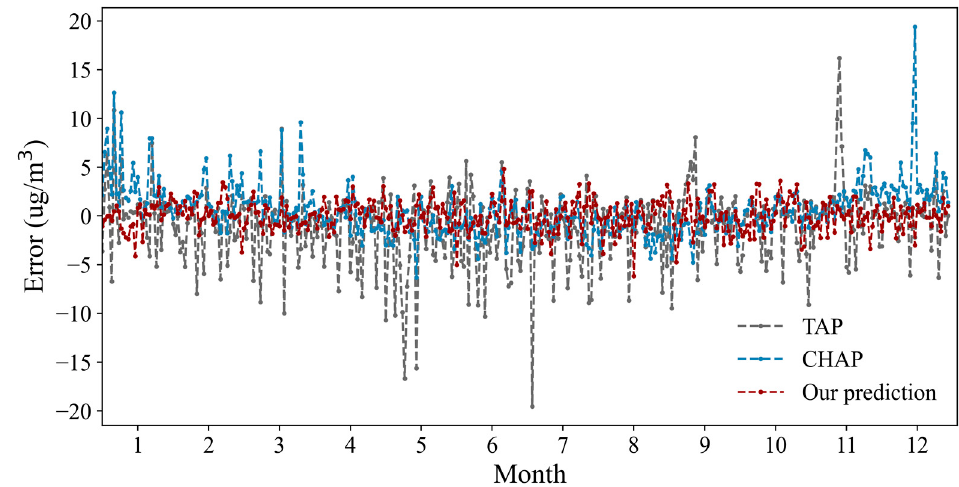
Figure 9. Errors between different ozone datasets and ground measurements.